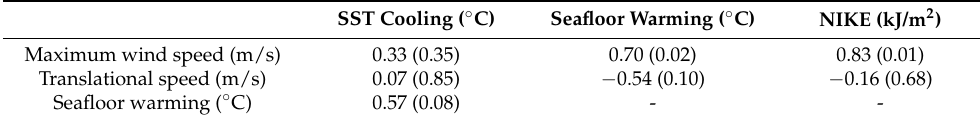
Table 2. Correlation coefficients and p -values (in the bracket) between the oceanic response (SST cooling, seafloor warming and NIKE) and typhoon characteristics (the maximum wind speed and translation